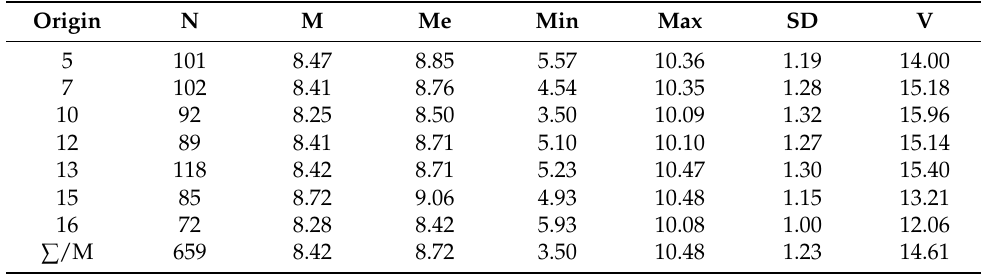
Table 5. Characteristics of JRc (km) of diverse genetic origins (N—Number of groups; M— Average; Me—Median; Min—Minimum; Max—Maximum; SD—Standard deviation; V—Coefficient of